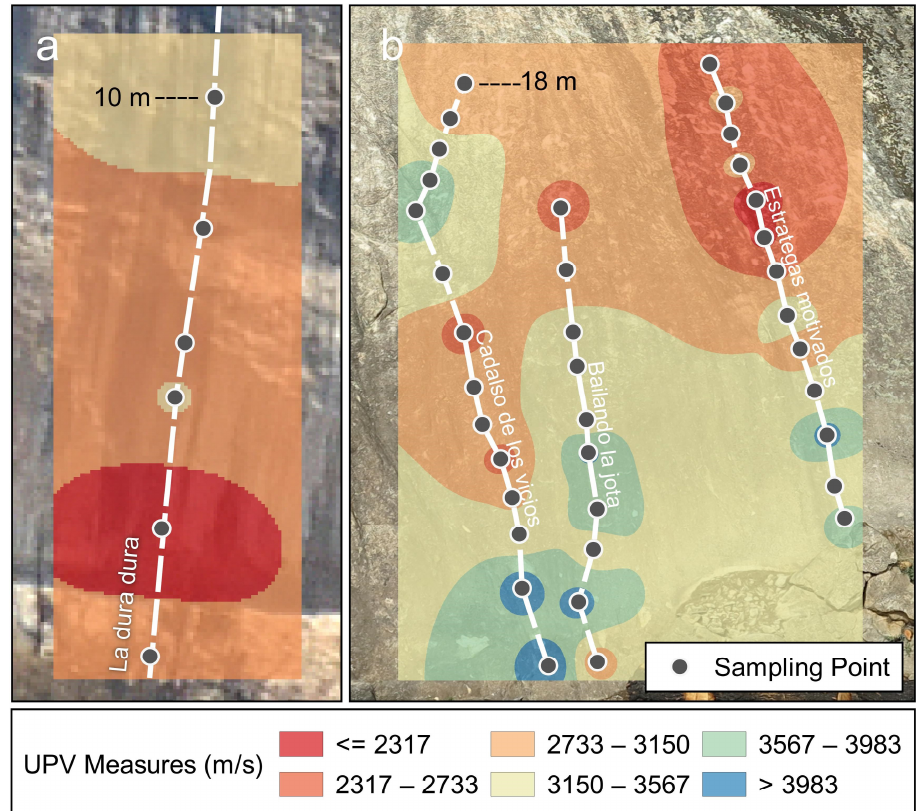
Figure 13. Spatial distribution of UPV measurements in: ( a ) “La Dura Dura” (Oliana) and ( b ) three routes in Site 6 of Cadalso de los